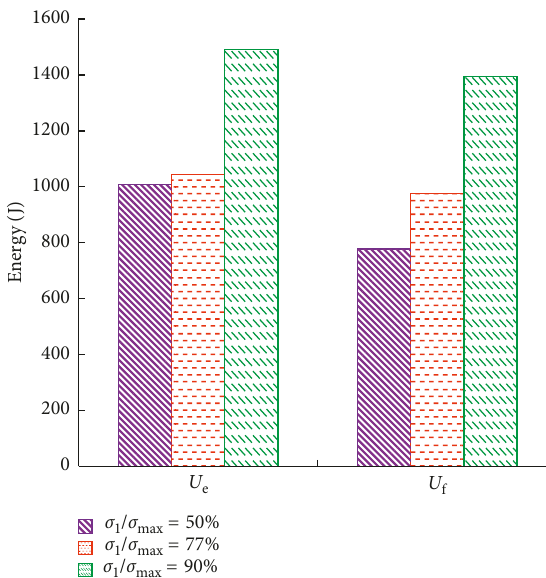
Figure 18: The comparison of the elastic strain energy under different support failure timings. Table 6: Testing results of one-single face true-triaxial unloading test with different support failure rates.